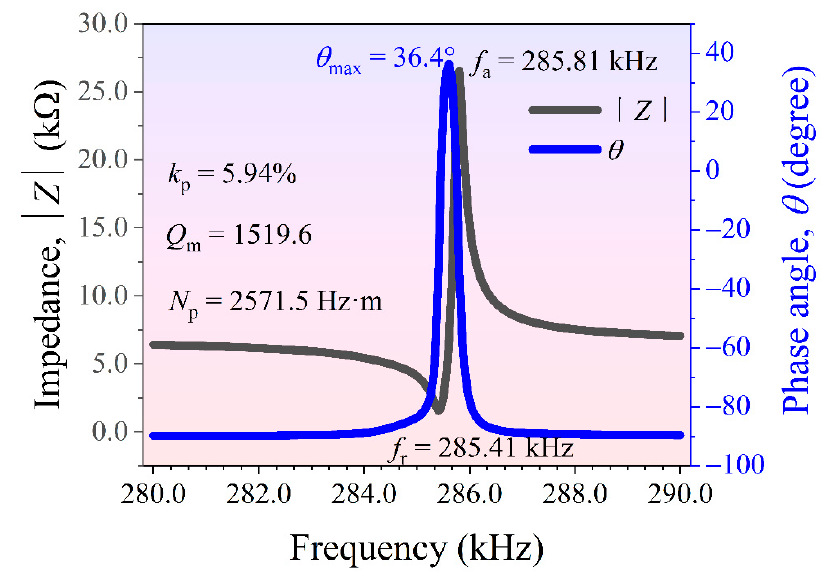
Figure 9. Electromechanical resonance spectroscopy of the BGTN − 0.2Cr ceramic at room temperature.